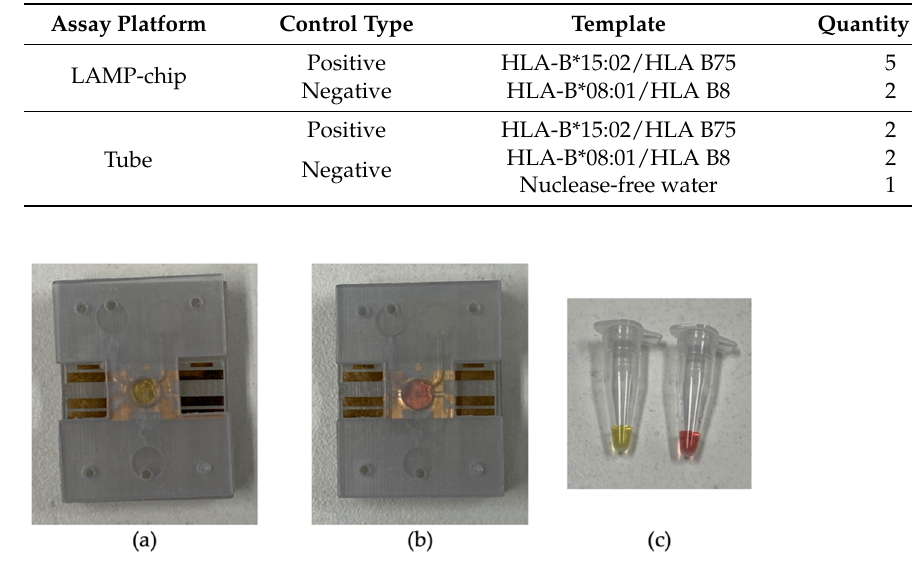
Figure 7. Representative photographs of the LAMP-chip and LAMP-tube after the amplification. ( a ) Positive control on LAMP-chip, ( b ) negative control on LAMP-chip, and ( c ) positive and negative control on LAMP-tube.